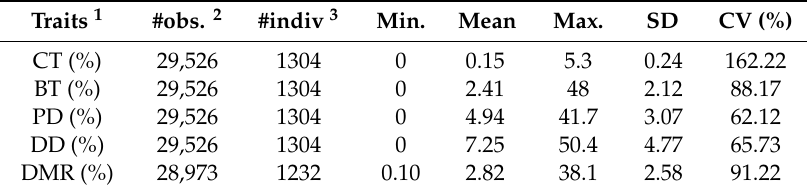
Table 1. Descriptive statistics of sperm morphology abnormalities in the Duroc boar